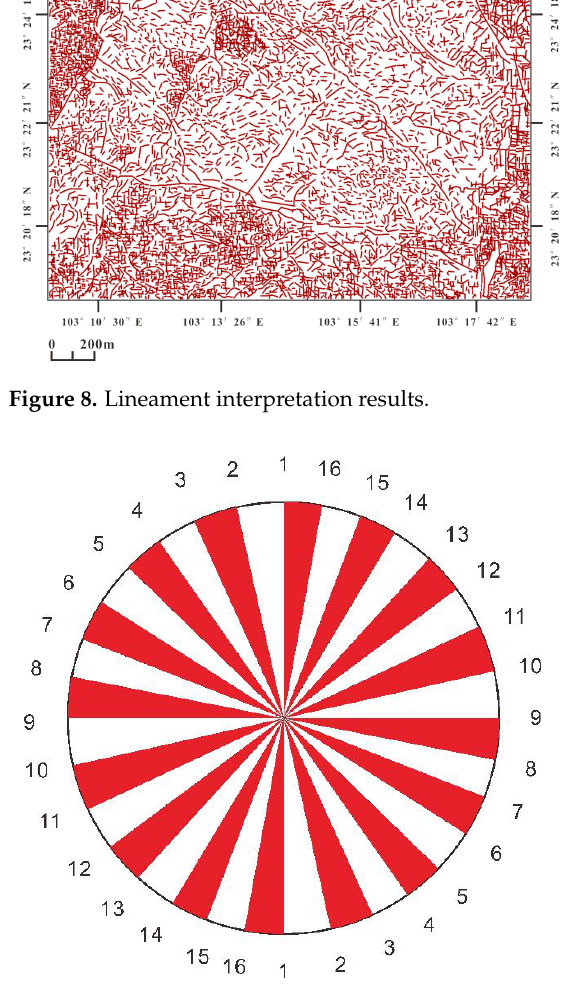
Figure 9. The 16 directions of the data search.